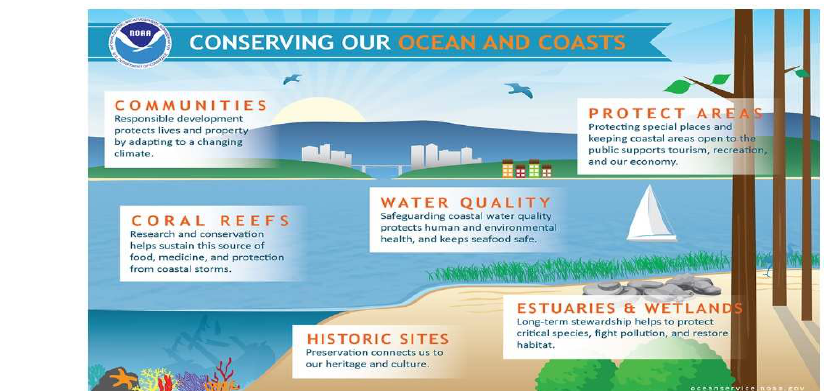
Figure 4. Official website of U.S Government: National Ocean and Atmospheric